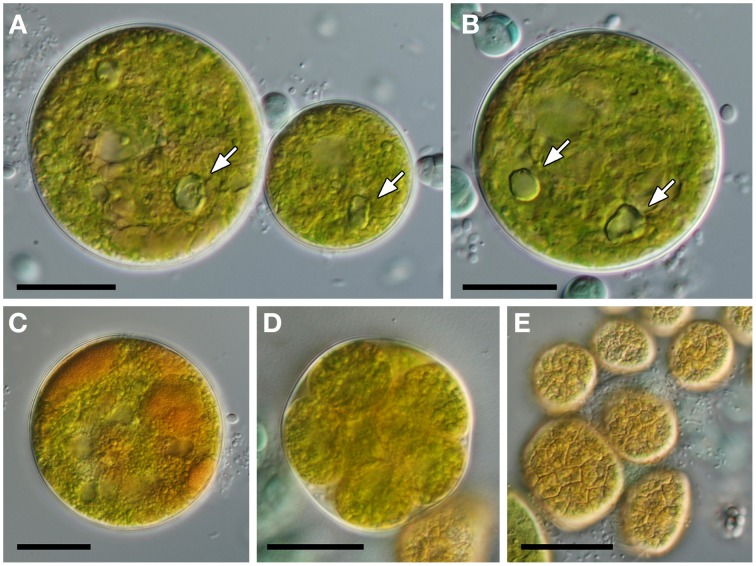
Morphology of cultivated green alga. (A) Size variability of vegetative cells. (B) Mature cell with a complex chloroplast and with several pyrenoids marked by arrows (in A,B). (C) Accumulation of orange color pigments. (D) Mature autosporangium. (E) Irregularly shaped autospores shortly after their liberation. Scale bars = 20 μm.